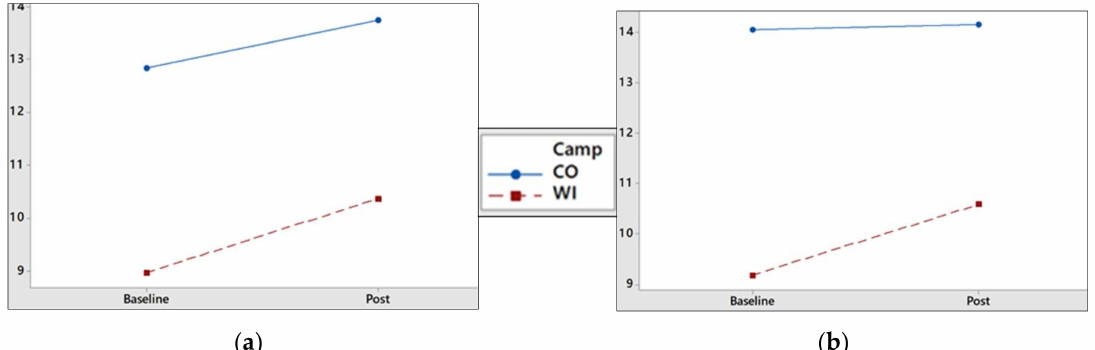
Figure 2. Visualization of differing changes in exercise and healthy eater role-identity between the Colorado (CO; health promotion) and Wisconsin (WI; obesity treatment) camps: ( a ) The magnitude of change from baseline to post-camp (Post) in ERI in the obesity treatment cohort appears greater than in the health promotion cohort; ( b ) An increase in HERI was observed in the obesity treatment cohort versus a plateau in HERI in the health promotion cohort (Baseline to